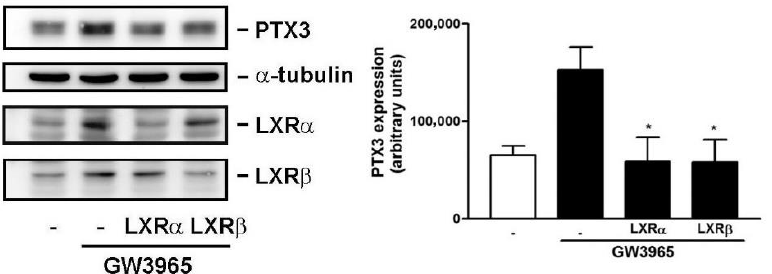
Figure 7. Effect of LXR siRNA interference on GW3965-induced PTX3 expression. Human fibroblasts were transfected with the indicated siRNA (-, control siRNA) and then treated with GW3965 (3 μM) for 16 h. Western blotting and densitometry were used to analyze the LXRα, LXRβ, PTX3 and α-tubulin expression ( n = 4). * p < 0.05 versus control (control siRNA (-) and GW3965 treatment).